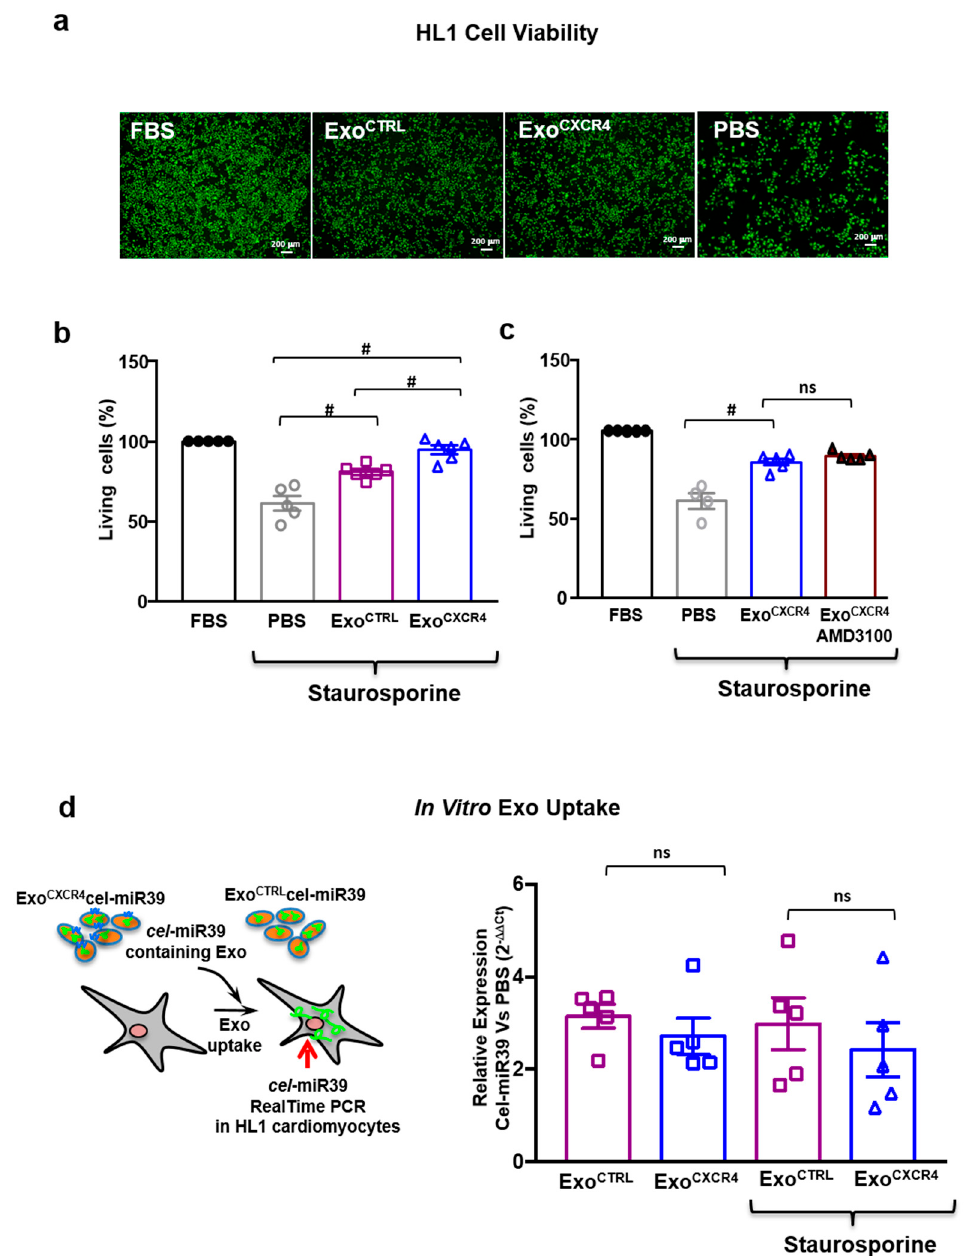
Figure 6. In vitro bioactivities of Exo CXCR4 . ( a , b ) Exo CTRL , and Exo CXCR4 inhibit staurosporine-induced death in HL-1 CM (green) ( n = 6 patients/group for Exo CTRL and Exo CXCR4 ; n = 5 repeated measurements for PBS and FBS) # p < 0.01 (one-way analyses of variance-ANOVA with post-hoc multiple comparisons using the Tukey-Kramer multiple comparison tests for paired parametric comparisons). Exo CXCR4 exhibit superior pro-survival effect. ( c ) Exo CXCR4 superior pro-survival effect in HL-1 CM is not affected by the addition of AMD3100 as specific CXCR4 antagonist. ( d ) In vitro Exo uptake. Real-time PCR analyses of cel-miR39 (mature sequence) levels in HL1 CM incubated with Exo CTRLcel-miR39 and Exo CXCR4cel-miR39 during normal or stress conditions. Data are 2 − ∆∆ C t values vs. PBS ( n = 5 patients/group).